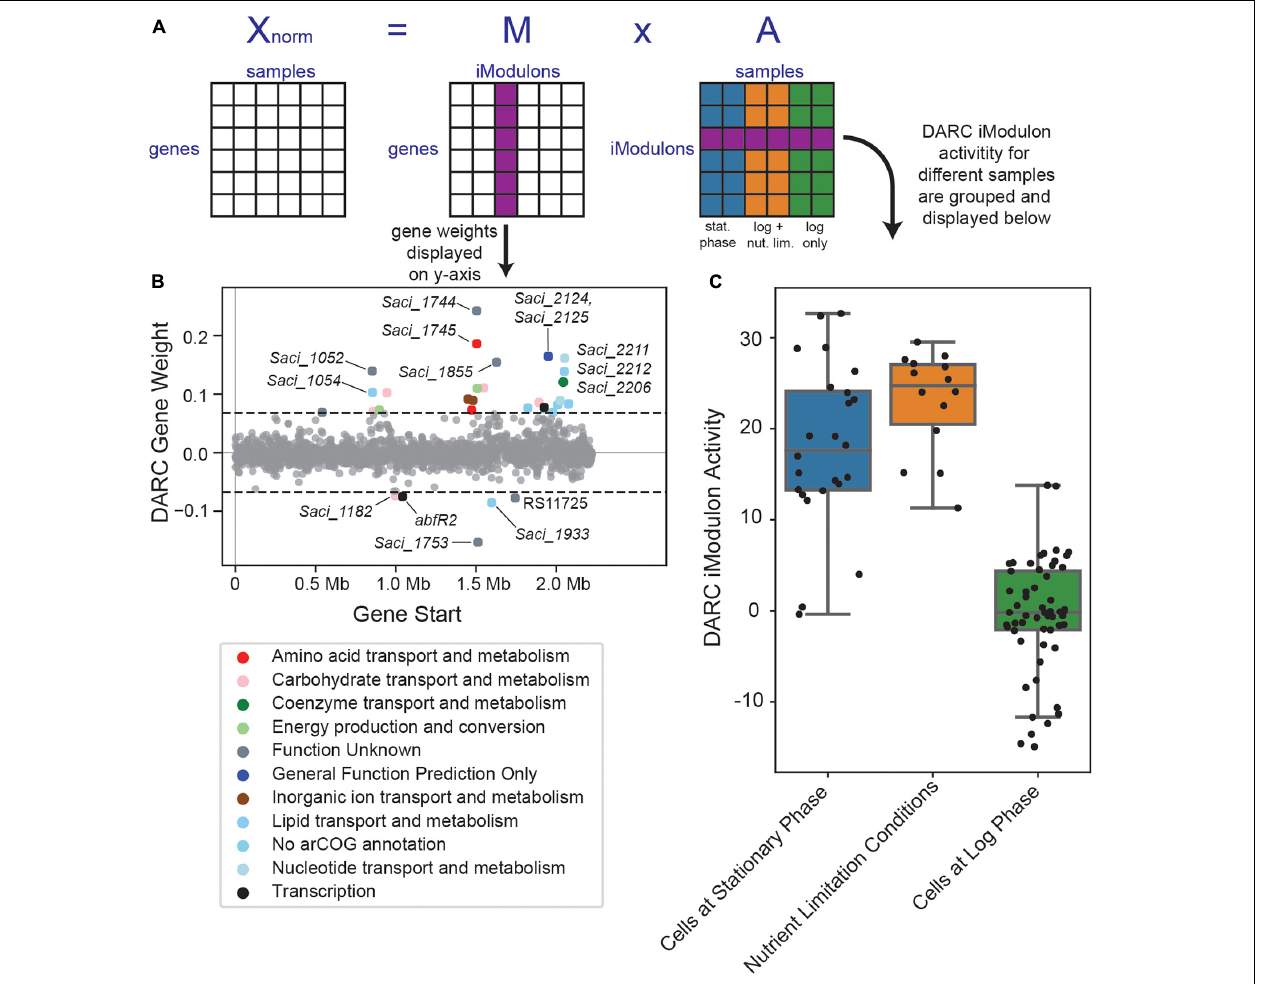
FIGURE 5 | Overview of the DARC iModulon. (A) Overview of the ICA decomposition process. The S. acidocaldarius Modulome ( X matrix) which consists of 95 high-quality RNA-seq datasets is decomposed into the M and A matrices (see section “Materials and Methods”). The gene weights from a particular column of the M matrix are used to generate the gene weight scatter plot (B) . The iModulon activities of the corresponding row of the A matrix are used to generate a corresponding boxplot (C) . (B) Scatter plot of the gene weightings for the DARC iModulon. Genes are colored by COG categories. (C) Boxplot showcasing the DARC iModulon’s activities for various conditions. Dots represent the iModulon activity for individual sample values. “Cells at stationary phase” includes all samples in the RNA-seq compendium which were collected for cells in stationary phase. “Cells at log phase” includes all samples in the RNA-seq compendium which were collected for cells in log phase, except for cells which were exposed to any nutrient-limitation conditions; “Nutrient Limitation Conditions” represents those such